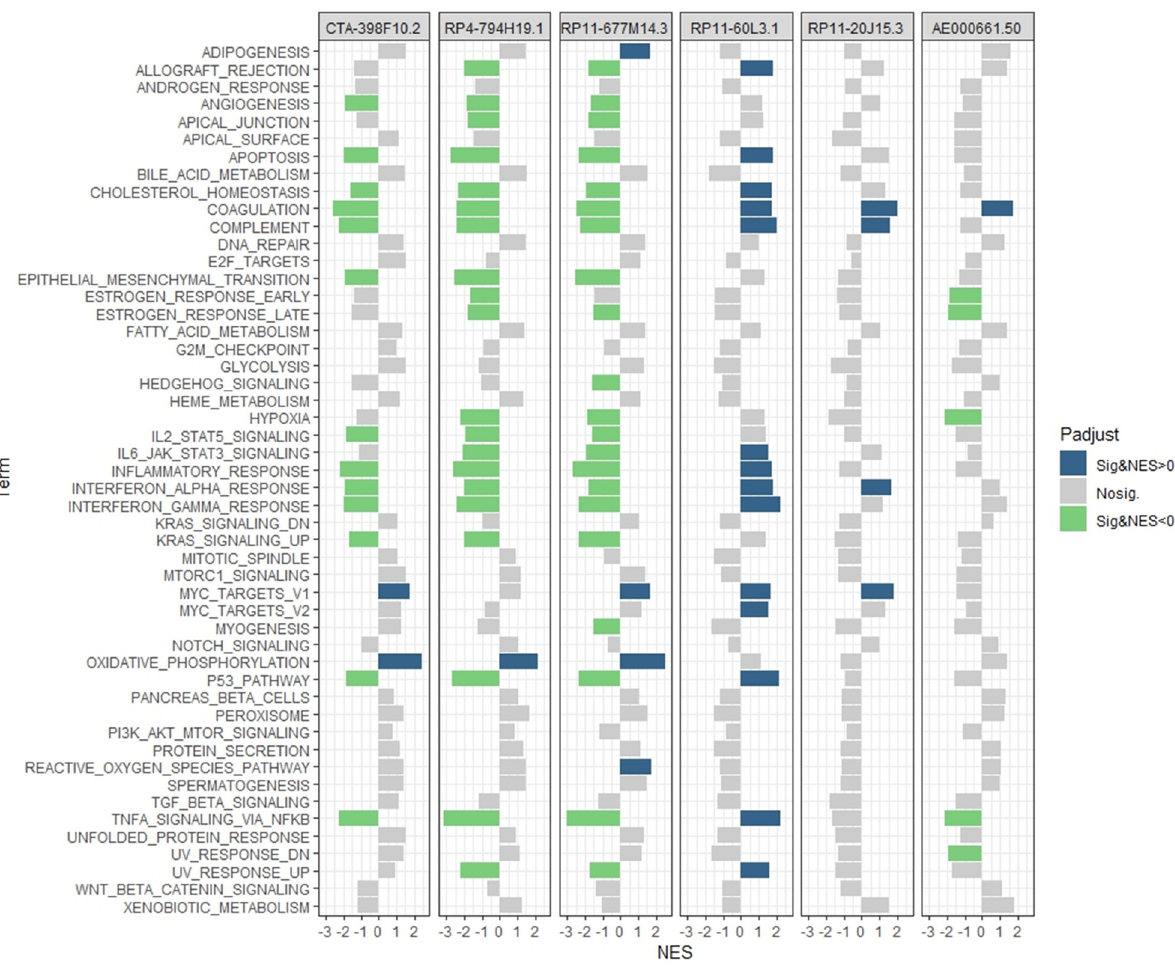
Figure 12: Hallmark pathways enrichment analysis between the thyroid cells with or without the corresponding LncRNA expression based on the single - cell RNA sequencing dataset GSE184362. NES, normalized enrichment